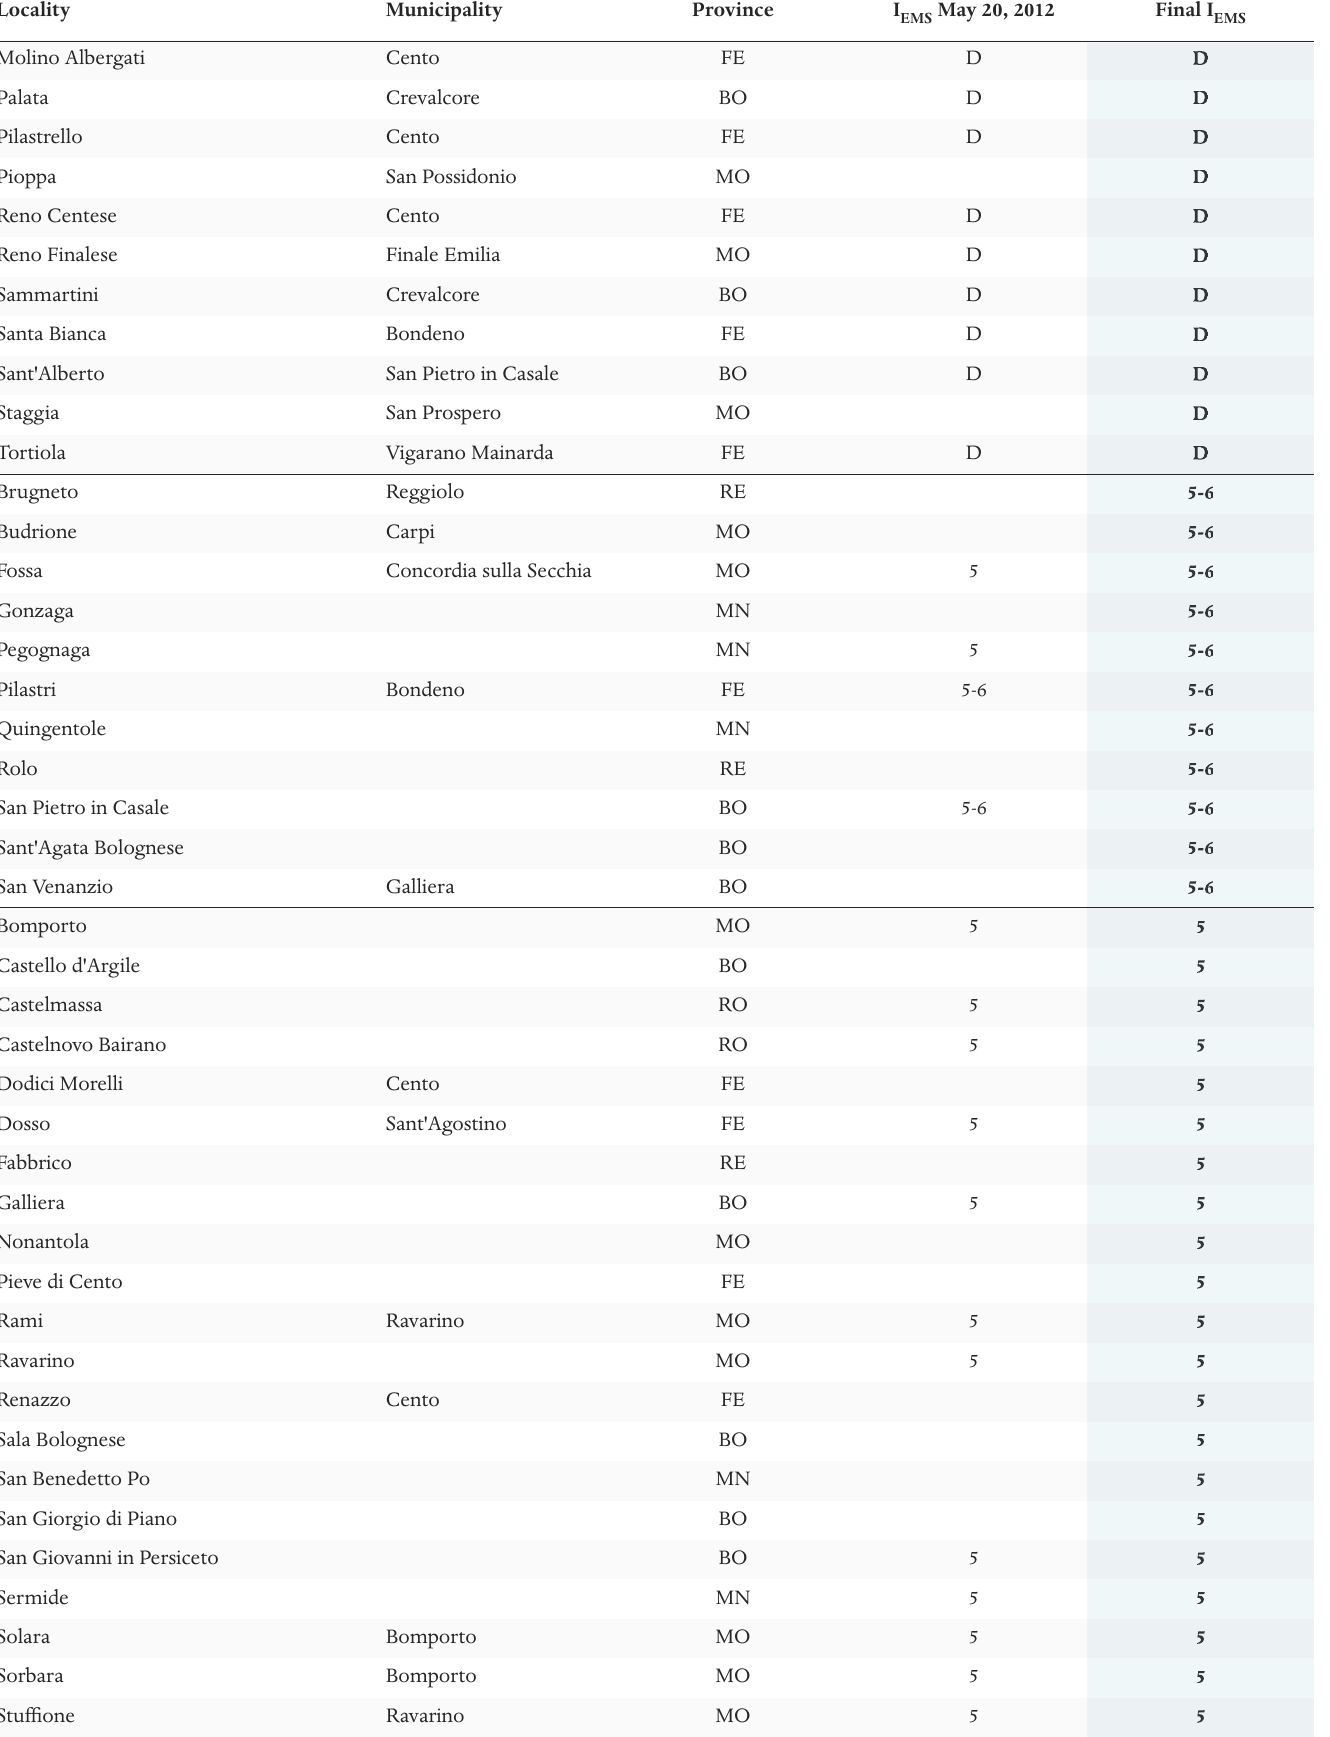
Table 1. Localities surveyed after the May-June 2012 seismic sequence. The data related to the May 20, 2012, are in the fourth